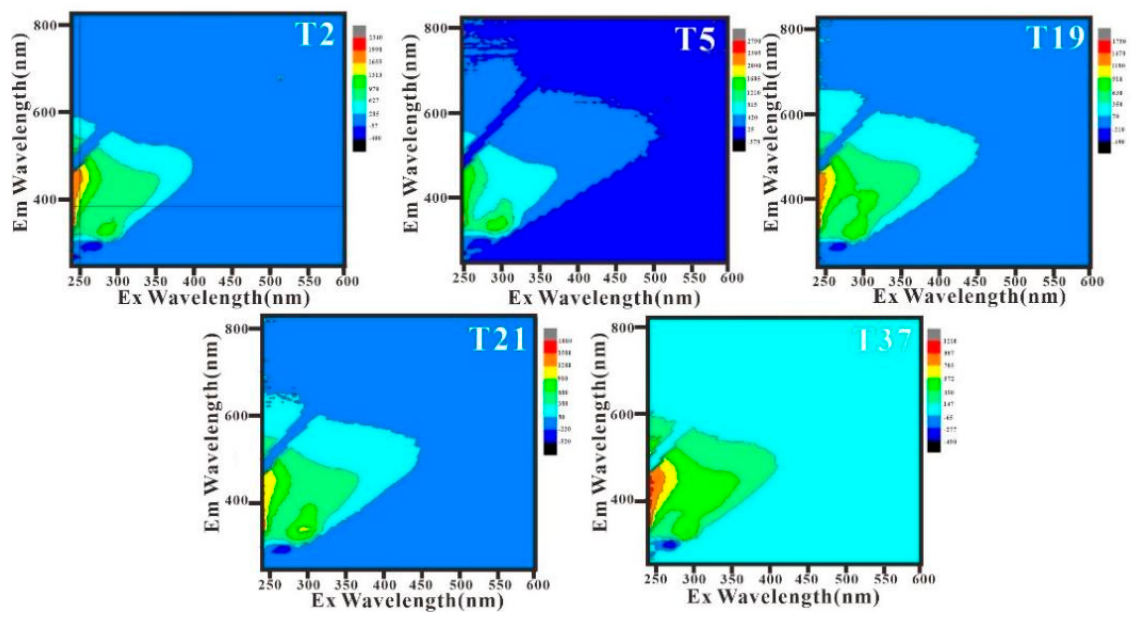
Figure 14. Three-dimensional fluorescence spectra of representative stations.